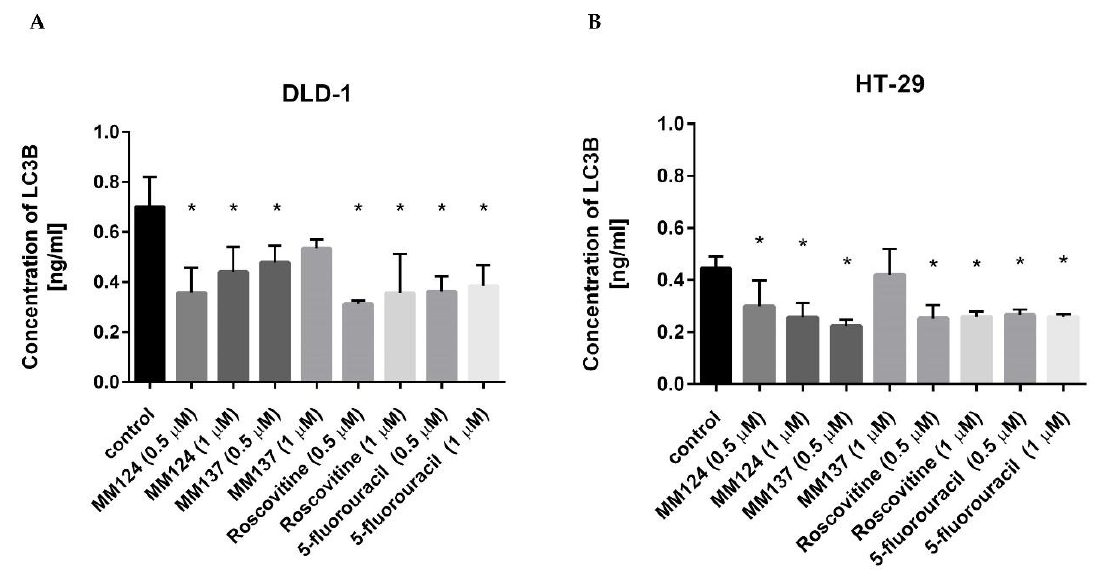
Figure 9. Concentration of LC3B in human DLD-1 ( A ) and HT-29 ( B ) human colorectal cancer cells after 24 h incubation with novel 7-methyl-5-phenyl-pyrazolo[4,3- e ]tetrazolo[4,5- b ][1,2,4]triazine sulfonamide derivatives (MM124, MM137), 5-fluorouracil, and roscovitine. Data is presented as mean ± SD from three independent experiments done in duplicate. * p < 0.05 vs. control group.